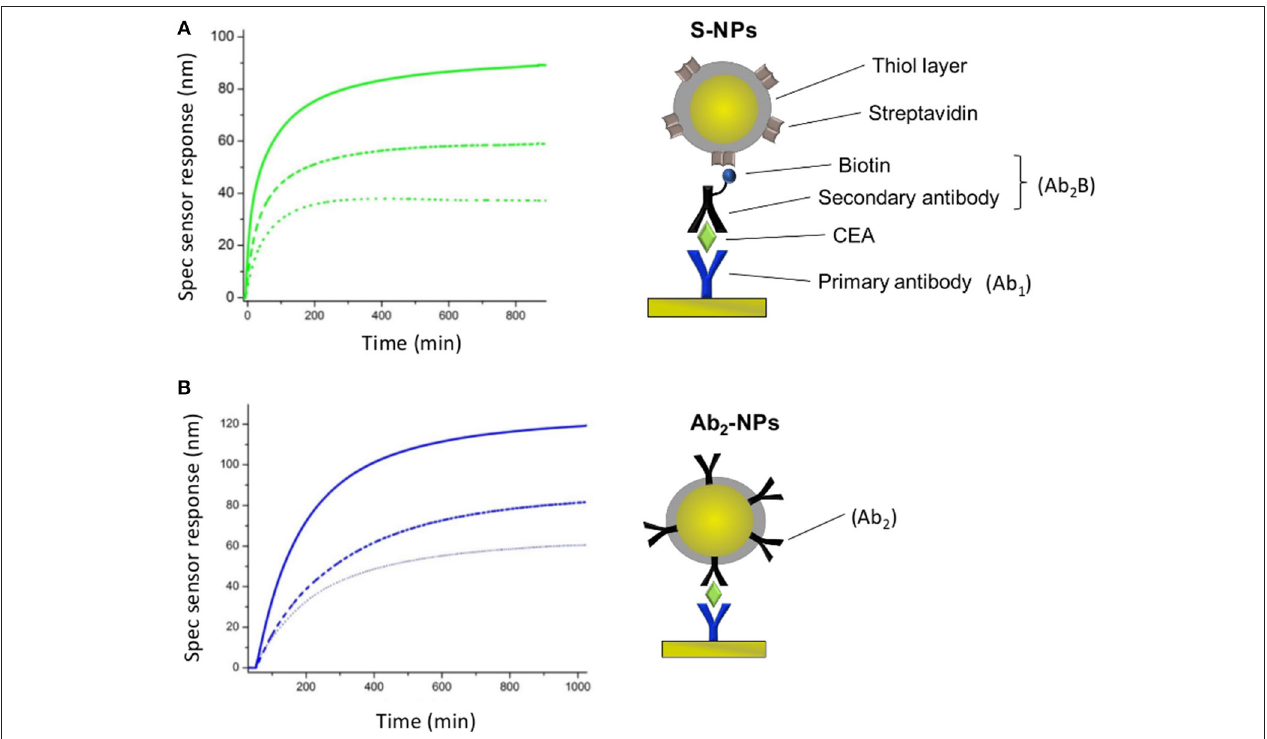
FIGURE 4 | Specific SPR sensor responses for S-NPs (A) and Ab 2 -NPs (B) measured for three different LDPNs. The solid lines, dashed lines and dotted lines correspond to a LDPN of 200, 50, and 20, respectively. All the measurements were performed in PBS BSA . All the sensor response data are